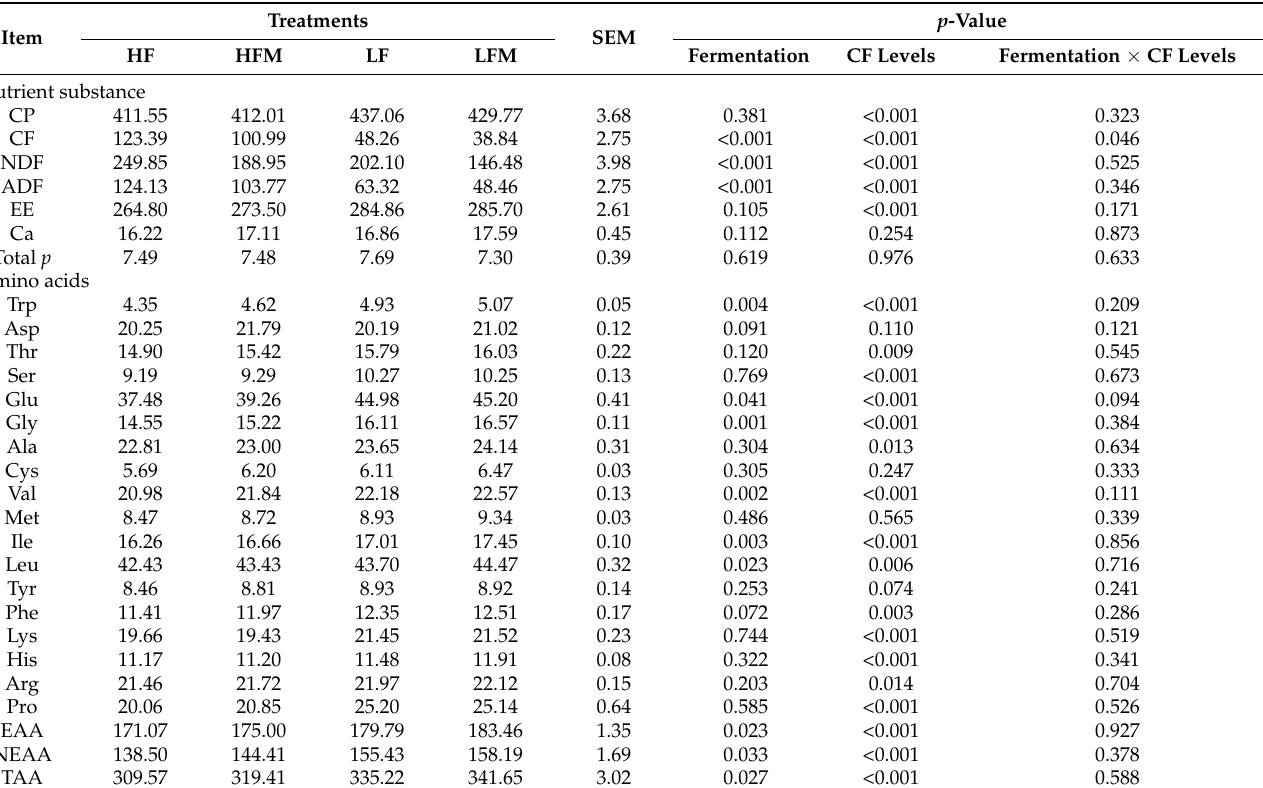
Table 4. Effects of multi-bacteria fermentation and dietary CF level on total tract digestion amount of CP, CF, EE, Ca, Total p , and amino acids in finishing pigs (g/day).